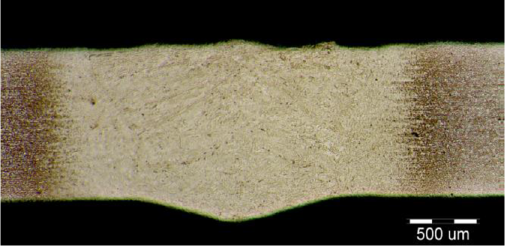
Figure 15. Macrostructure of a welded joint. Samples C (TRIP).